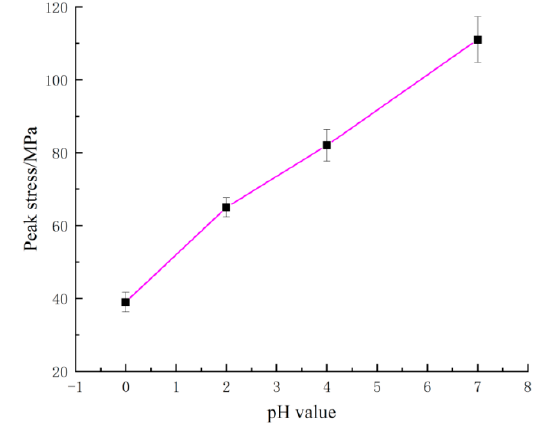
Figure 3. Peak stress–pH value curves of lamprophyre .